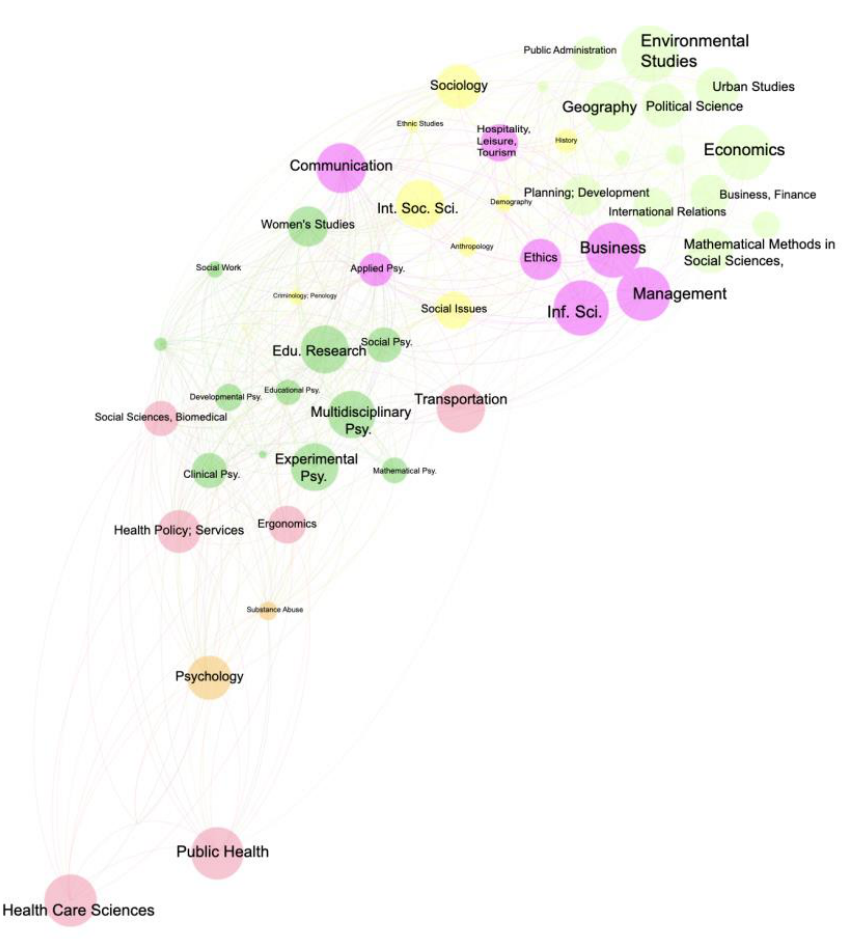
Figure 4. Focused view of Social Sciences related clusters in Subject Categories of social sciences articles between 2015–2020, based on the Big Data and AI analytics search terms. Source: WoS (11,007 articles).